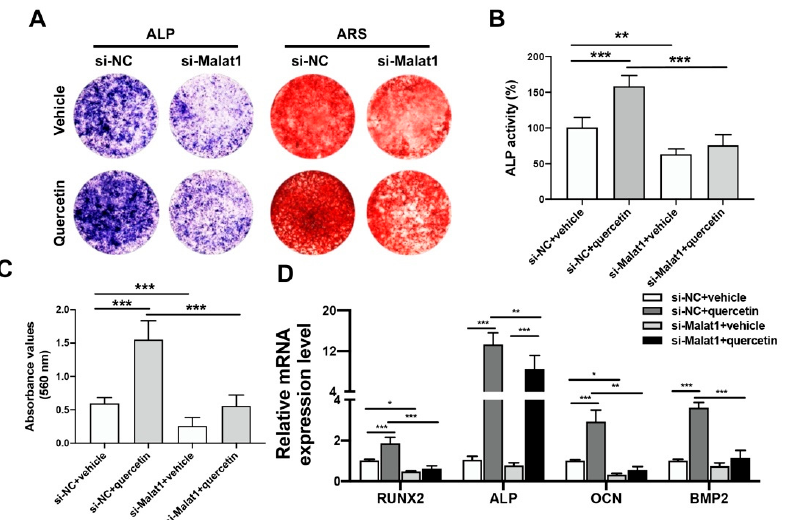
Figure 5. Malat1 mediated the rescuing effect of quercetin on TNF α -impaired BMSCs osteogenesis. ( A ) The BMSCs were Malat1 knockdown, pre-conditioned with TNF α for 12 h and treated with quercetin during osteo-induction for 7 days. ALP activity and calcified nodules formation were examined by ALP activity assay and ARS staining, respectively. ( B , C ) Quantitative analysis of ALP activities ( B ) and ARS staining intensities ( C ). ( D ) The mRNA expression level of osteogenesis markers, including Runx2, Alp, Ocn and Bmp, were measured by real-time PCR ( n = 6; * p < 0.05, ** p < 0.01, *** p < 0.001).